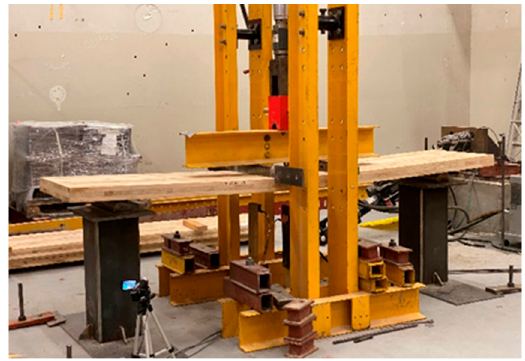
Figure 1. Bending tests on E. nitens CLT panels.